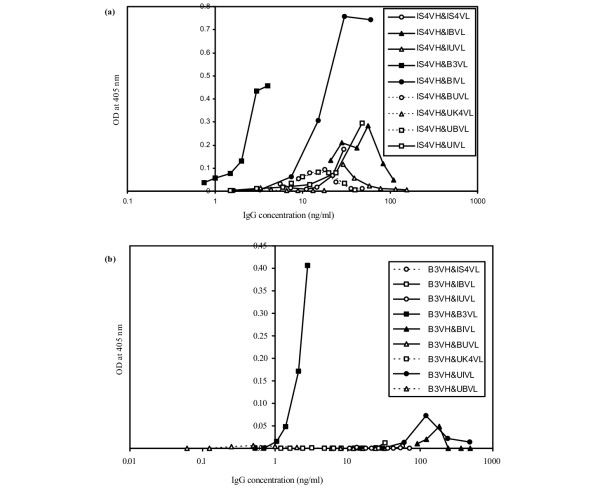
Effect of complementarity determining region exchange in the light chains. Cardiolipin binding of IgG in COS-7 cell supernatants containing wild-type heavy chains expressed with wild-type or hybrid light chain constructs. (a) Light chains expressed with IS4 variable heavy chainregion (VH). (b) Light chains expressed with B3VH. Presented as concentration of IgG in the supernatant versus optical density (OD) at 405 nm in the anti-cardiolipin ELISA.